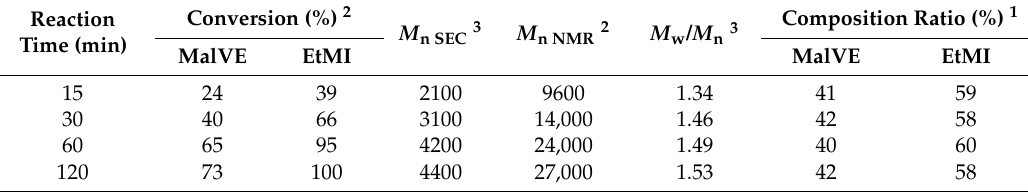
Figure 4. 1 H NMR spectrum of poly(MalVE- co -EtMI) in D 2 O. Table 1. RAFT copolymerization of MalVE and EtMI 1 .